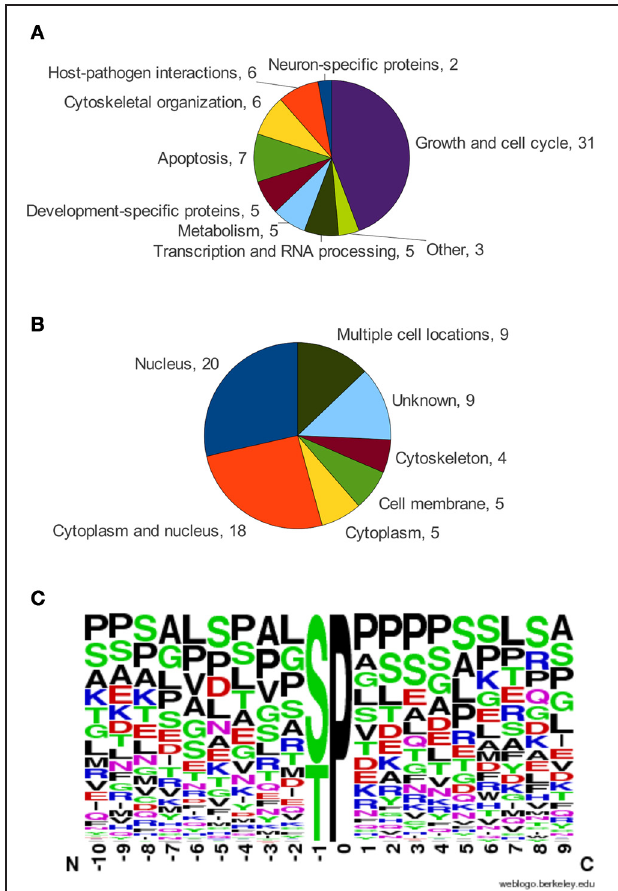
FIGURE 4 | (A) Functional categorization of Pin1 interactors. (B) Subcellular location of Pin1 interactors, from UniProtKB. (C) Frequency chart of amino acids in the alignment of Pin1 binding sites oriented at the S/T-P motif, using the WebLogo service (Schneider and Stephens, 1990; Crooks et al.,